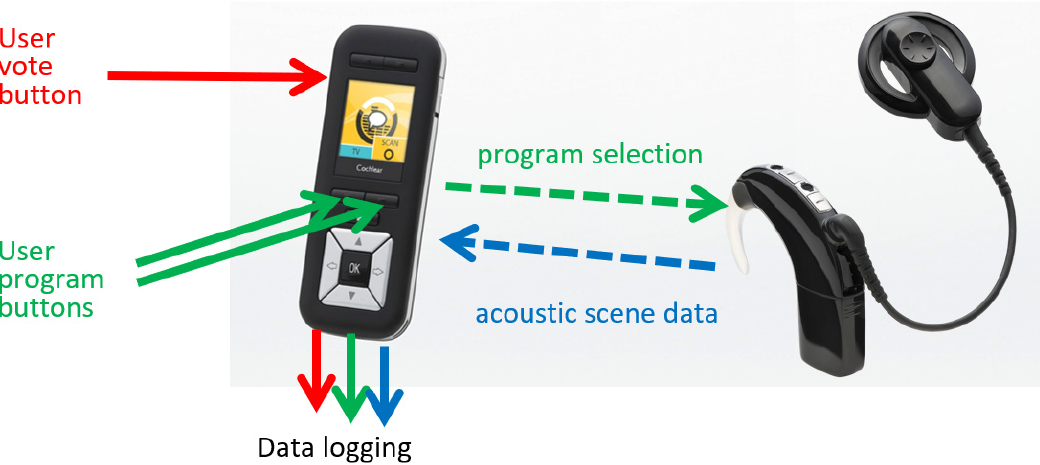
Figure 1. The CP900 sound processor and CR230 remote control used to capture EMA data.